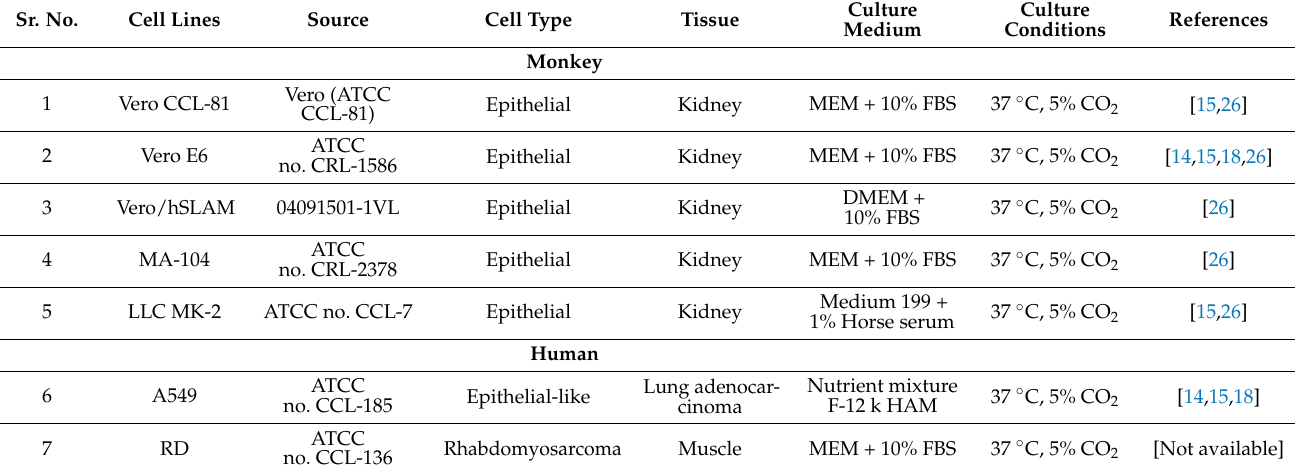
Table 1. List of cell lines tested for susceptibility studies with SARS-CoV-2 Omicron BA.1.1 variant. Sr.